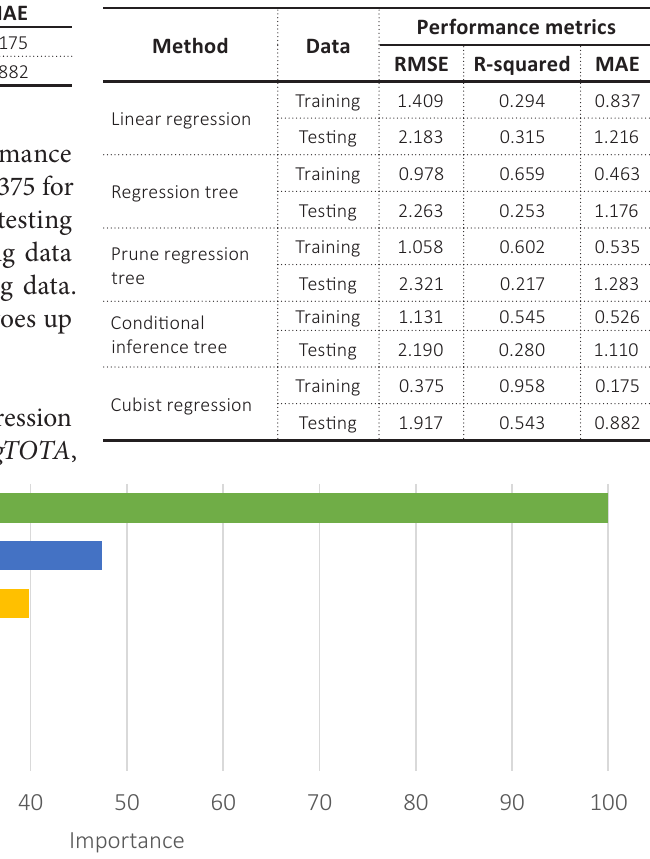
Figure 9. Cubist regression variable importance scores for EPS